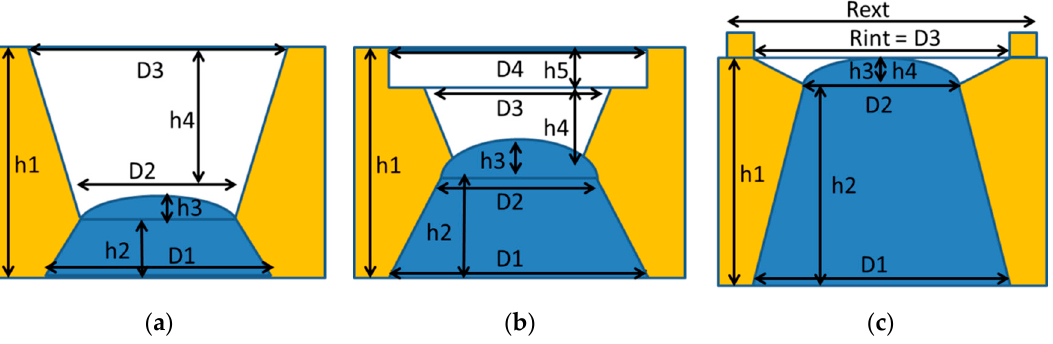
Figure A2. Refractive index n dispersion for the DBR layers reported in Figure A1.